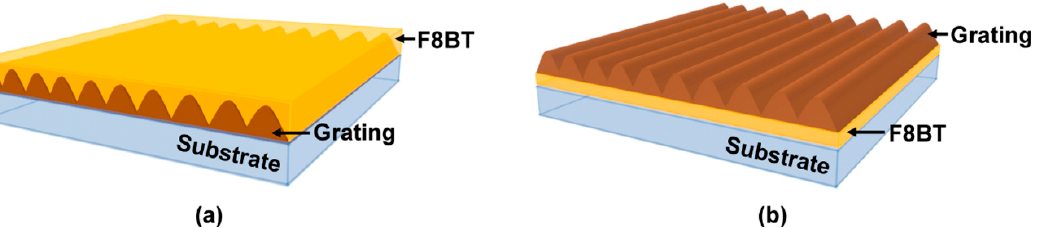
Figure 1. Schematic diagram of distributed feedback (DFB) polymer lasers based on ( a ) Schematic diagram of distributed feedback (DFB) polymer lasers based substrate/grating/active waveguide (SGA) structure and ( b ) substrate/active waveguide/grating (SAG) structure.